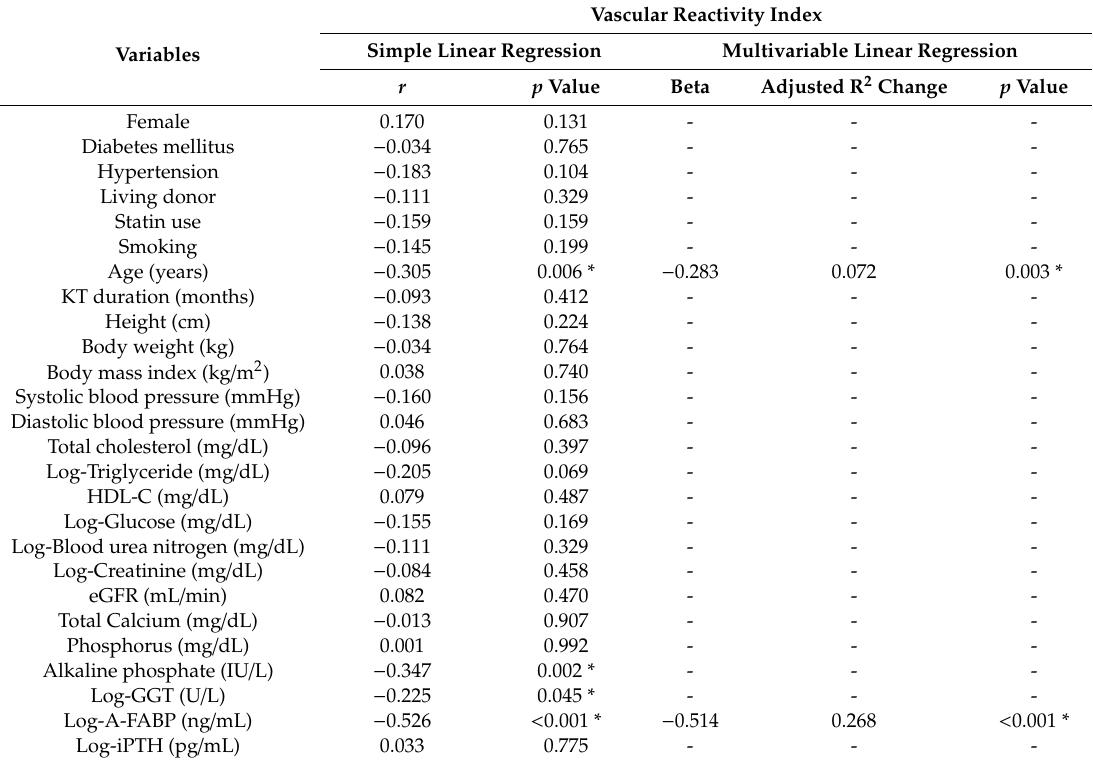
Table 2. Correlation of vascular reactivity index levels and clinical variables by simple or multivariable linear regression analyses among 80 KT